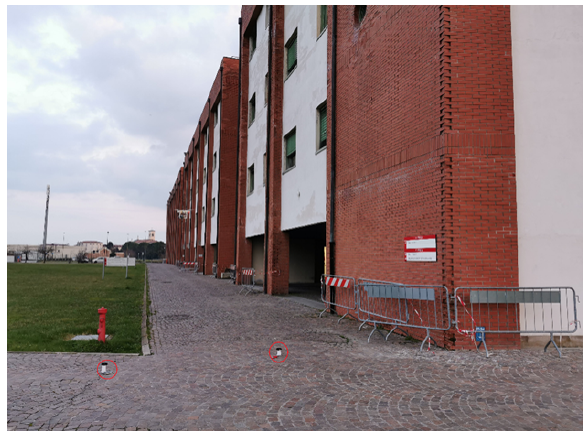
Figure 2. Pozyx UWB anchors distributed on the ground close to the building fac¸ade.